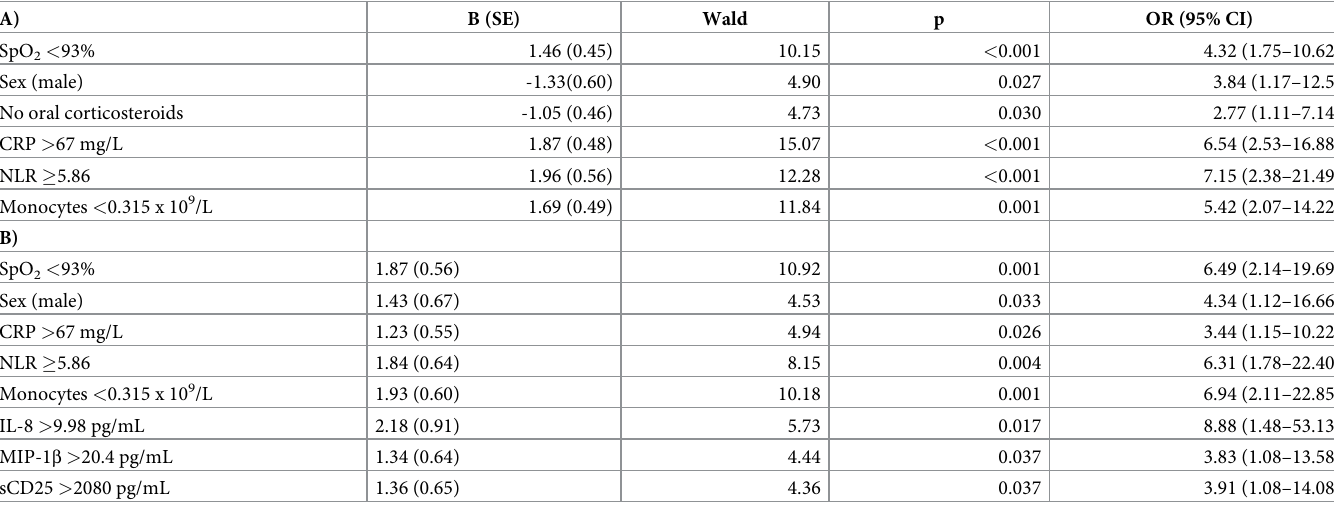
with discharge during the first week, with PPV and NPV of 74.4%, and 68.9%, respectively, val- ues too low for clinical application. Among the cytokines analyzed, only lower concentrations of IP-10 and higher concentrations of IL-1 β were associated with a better prognosis and Table 3. Predictive models for worsening during the first week among mild patients at